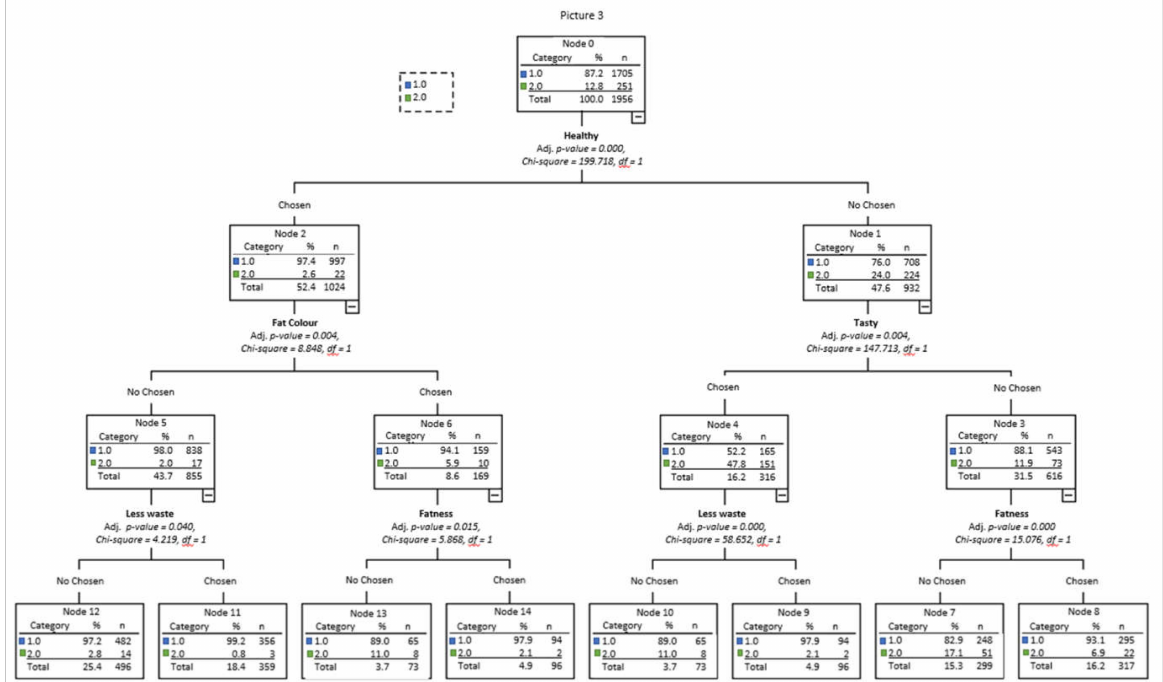
Figure 5. Decision tree for Picture 3 as a function of sociodemographic variables, purchase habits, beliefs, and the criteria used in the